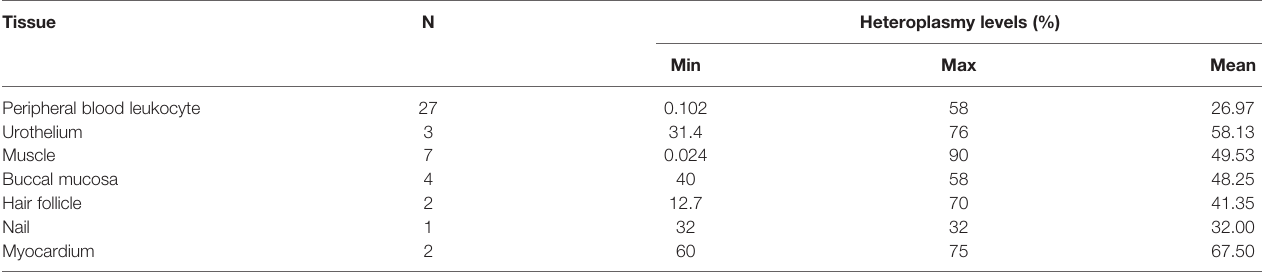
TABLE 1 | The heteroplasmy levels of the m.3243A>G mutation in different tissues.